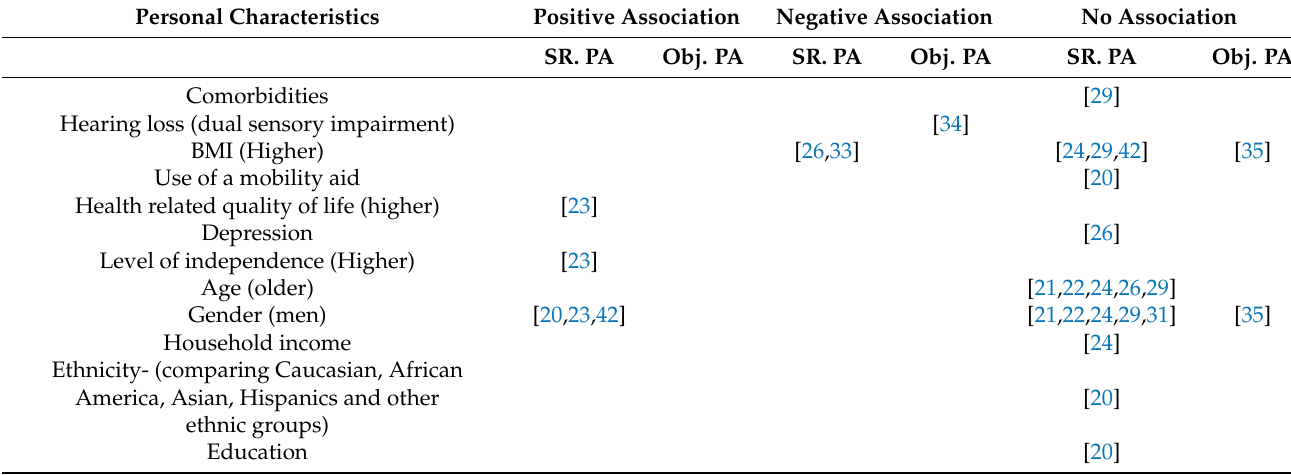
Table 5. Personal non-modifiable variables and their association with